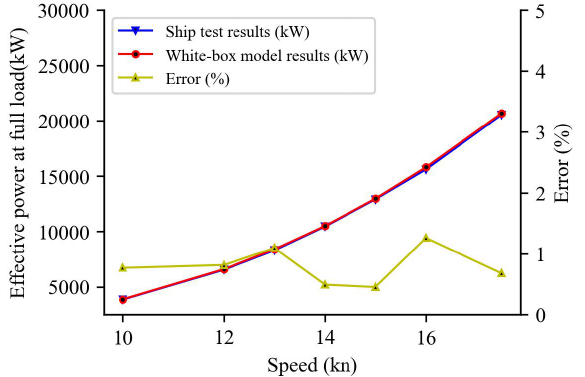
Figure 10. Still water resistance effective power at full load.